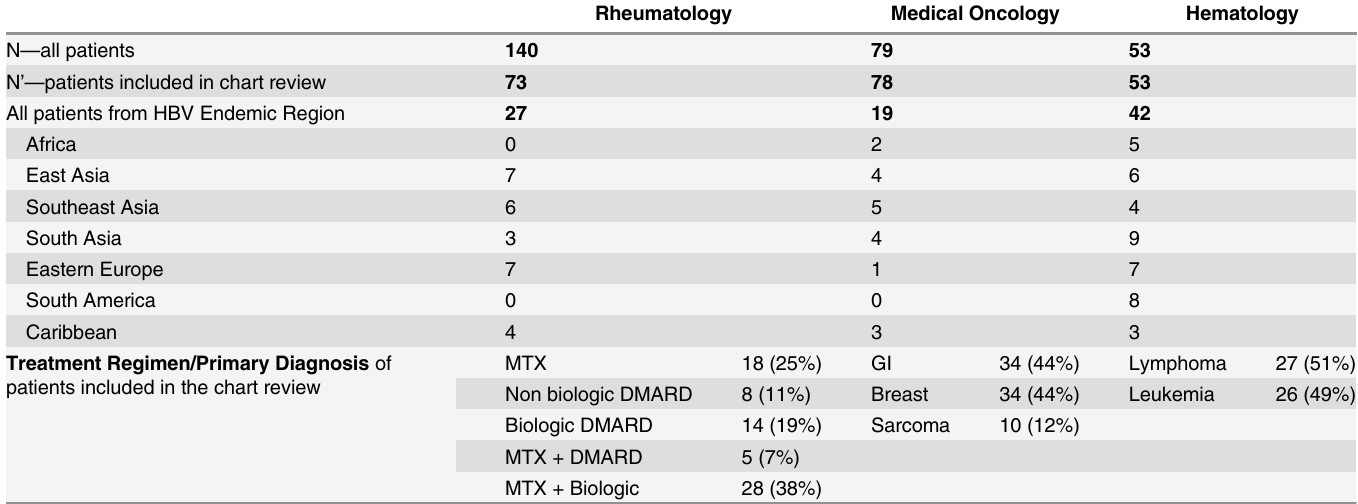
Table 2. Patient